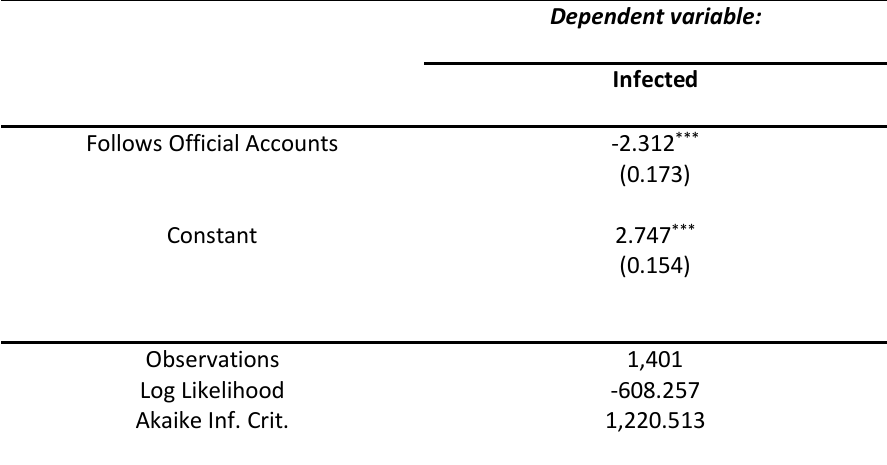
Table 5. Logistic regression